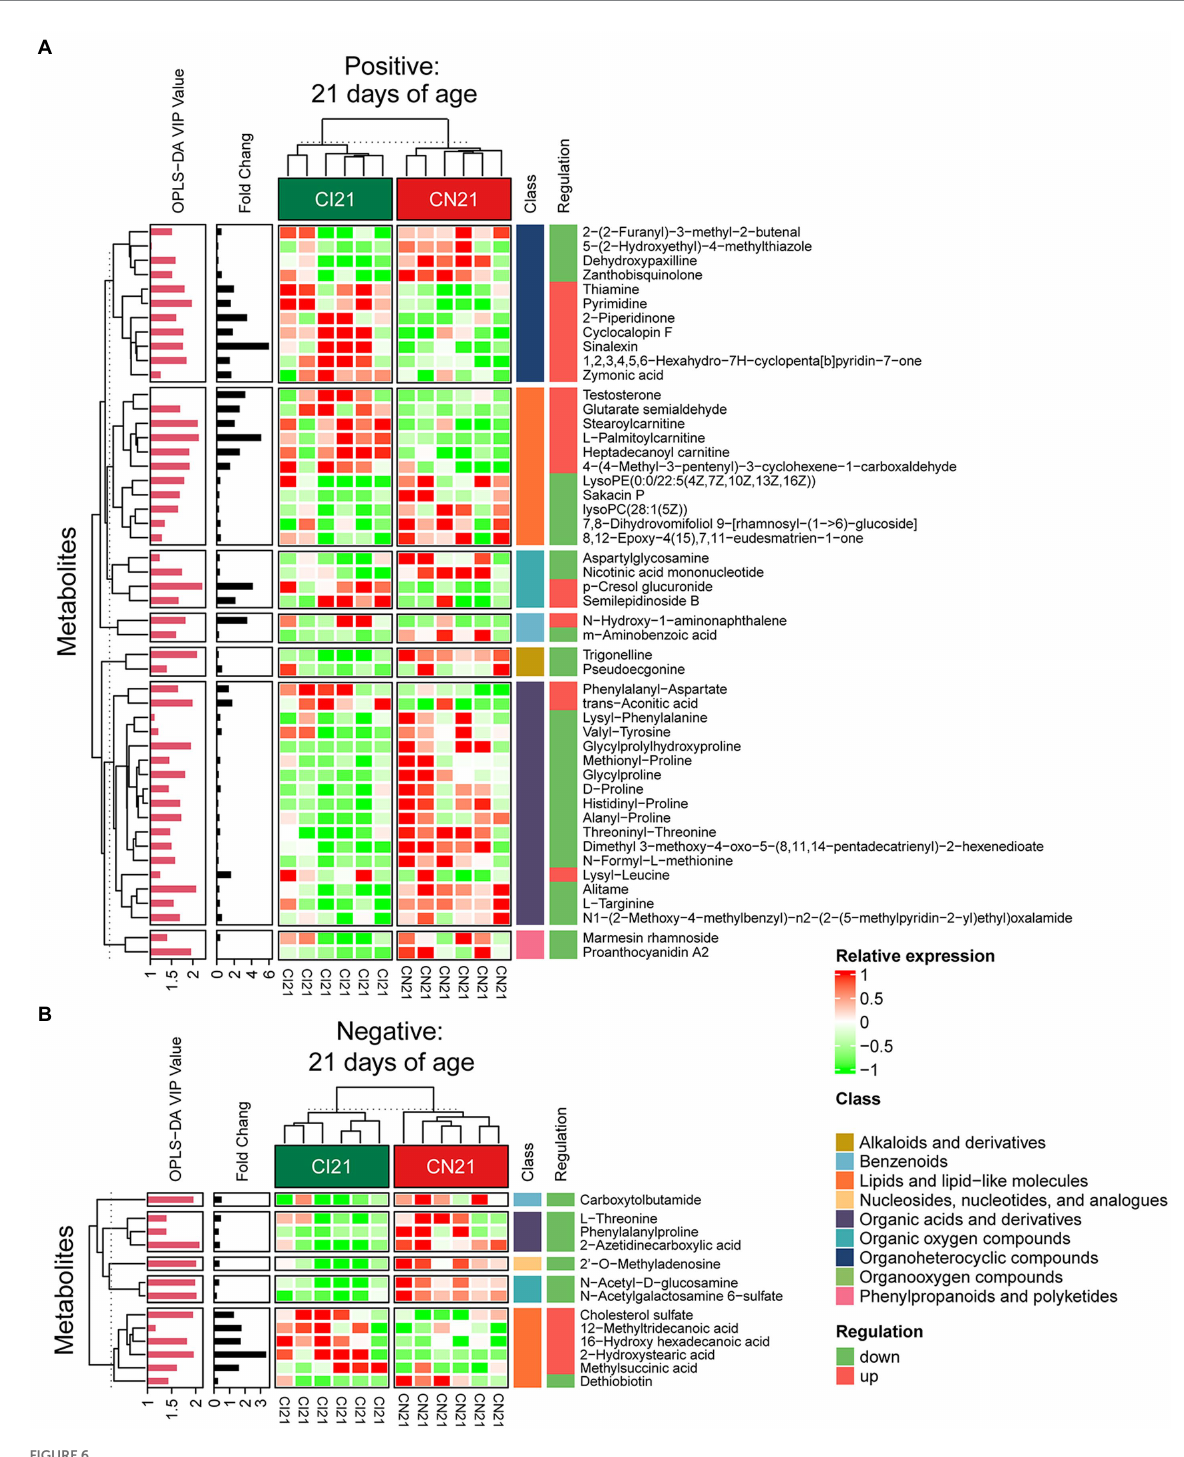
FIGURE 6 Hierarchical clustering analysis for different metabolites with MS2 based on the non-target metabolomics of the colonic contents between the intrauterine growth restriction (IUGR) and normal birth weight (NBW) piglets at 21 days of age ( n = 6). (A,B) represent positive and negative ion models, respectively. The relative metabolite level is depicted according to the color scale. Red indicates significant up-regulation ( p < 0.05), and green indicates significant down-regulation ( p <